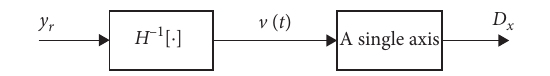
Figure 3: The principle of the feedforward compensation control.